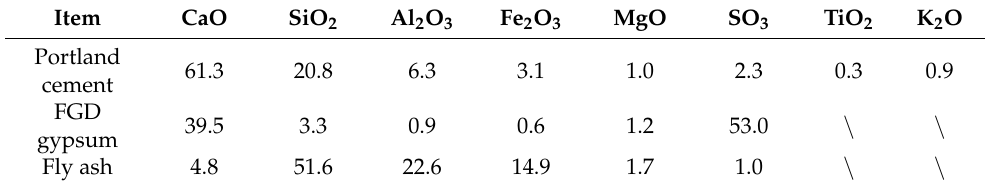
Table 1. The chemical composition of P.II.52.5 Portland cement, FGD gypsum, and fly ash (wt/%).